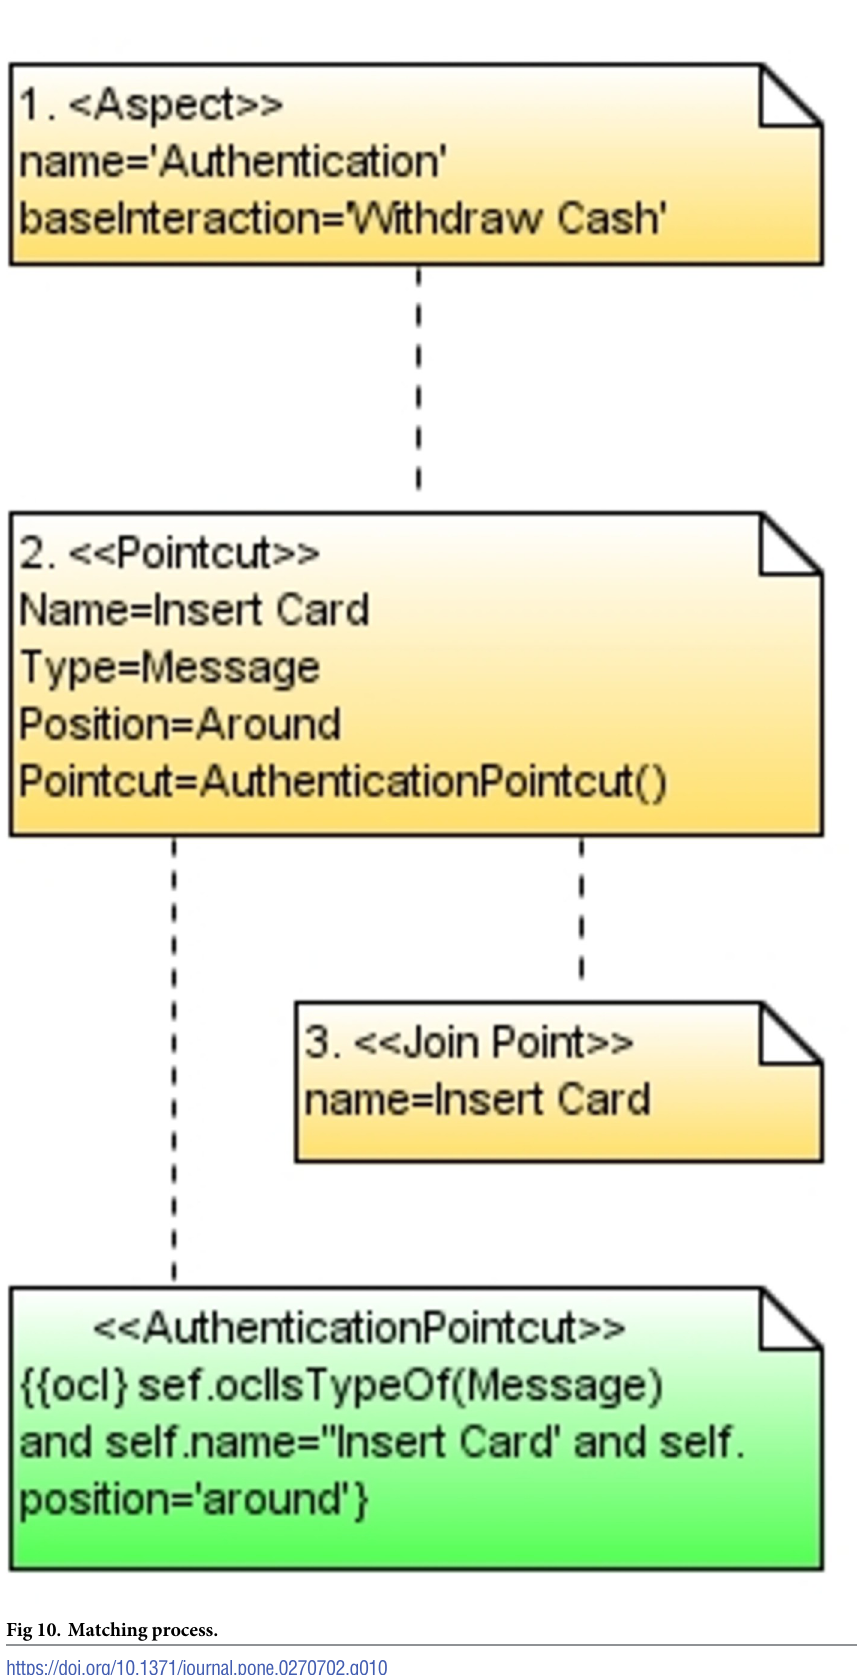
Fig 10. Matching